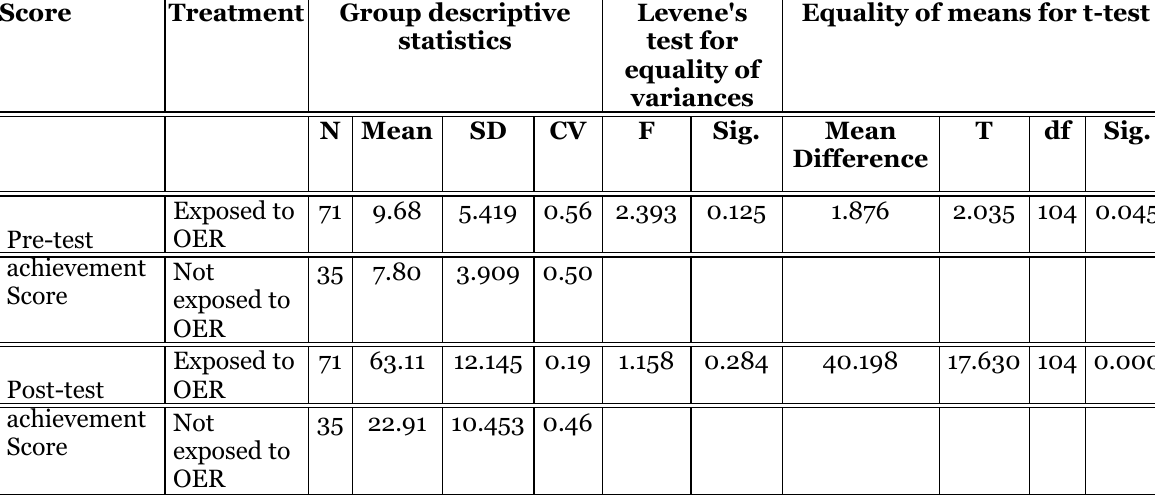
Descriptive Statistics and t-test for Equality of Means Score